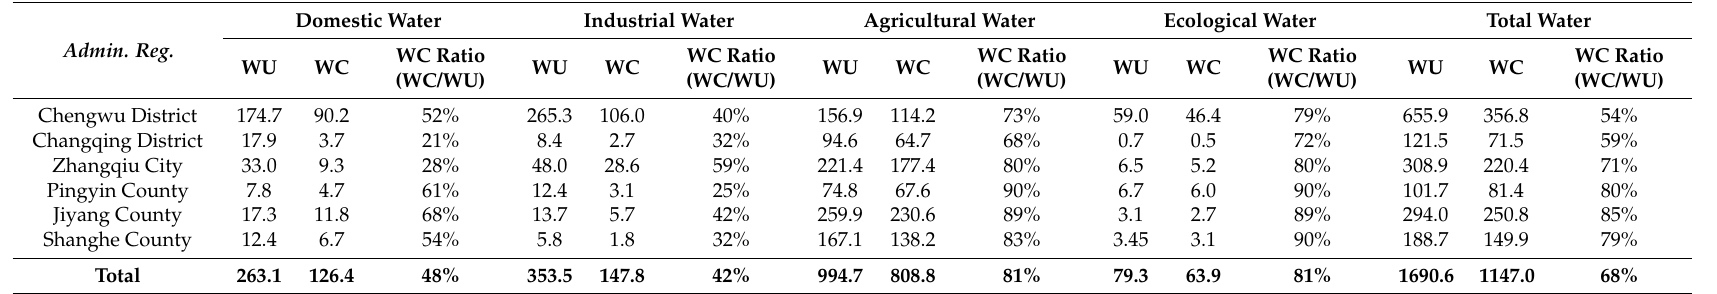
Table 6. Off-stream water usage (WU) and consumption (WC) in the base year (units: million m 3 ).